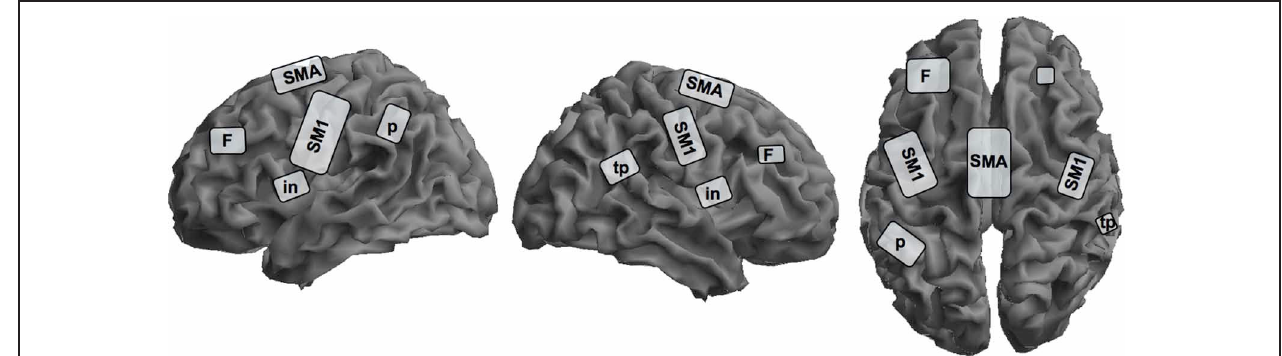
FIGURE 2 | Schematic overview of cortical representation of mental rehearsal of singing an Italian aria in singers with different levels of professionalism on a segmented gray matter cortex. Imagined singing shows cortical activation in the bilateral primary sensorimotor cortex, SM1; insula, in; prefrontal lobe, F; left inferior parietal lobe,